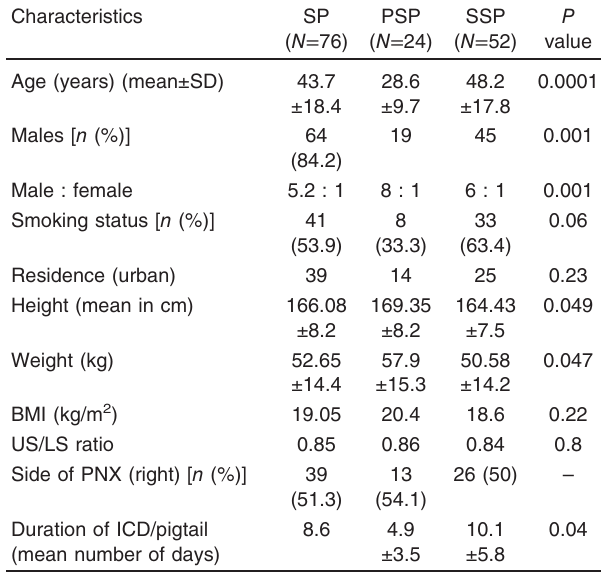
Table 2 Clinical profile of patients with pneumothorax